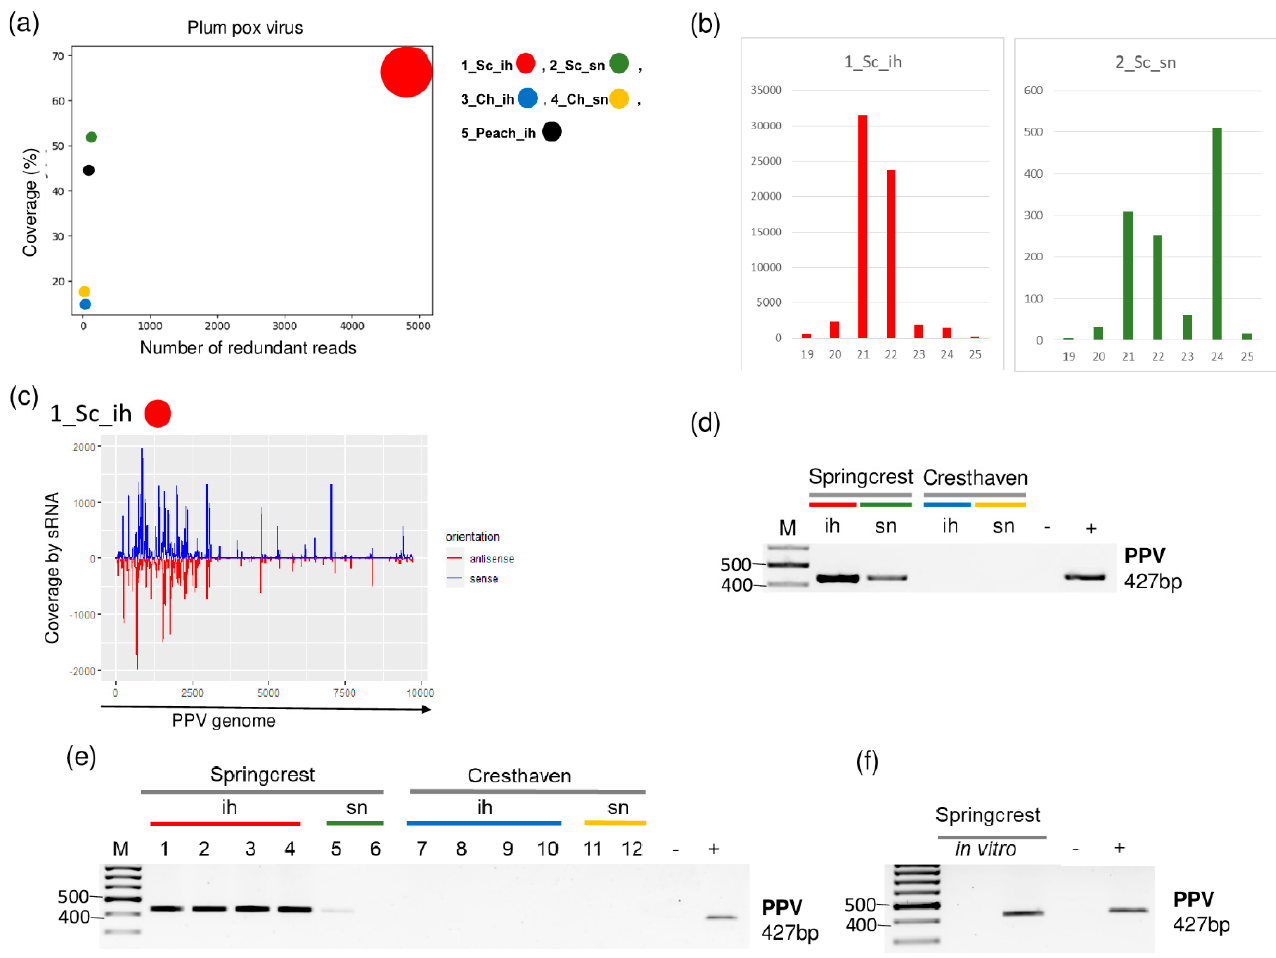
Figure 2. The result of the sRNA HTS and its validation for PPV in the five sRNA libraries. ( a ) The graphic representation of the result of the bioinformatics analysis of sRNA HTS. The coverage of the PPV genome ( y -axis) together with the number of RPM (number of PPV-specific non-redundant reads in 1 million sequenced reads, on the x -axis) was plotted as a circle whose diameter is proportional to the number of contigs. Different colors were used for the five libraries, as indicated. ( b ) The size class distribution of the PPV-derived reads in 1_Sc_ih and 2_Sc_sn libraries. ( c ) PPV-derived reads in the 1_Sc_ih library are shown as they mapped to the PPV genome, indicating their sense and antisense origin. ( d ) The result of RT-PCR validation for the presence of PPV in the 1–4 sRNA HTS libraries using PPV-specific primers amplifying a 427 bp virus-specific amplicon. ( e ) The result of the RT-PCR validation for the presence of PPV in individual trees of 1–4 sRNA libraries using virus-specific primers amplifying a 427 bp virus-specific amplicon. ( f ) The result of the RT-PCR validation of PPV in in vitro plantlets whose ancestors were used, using PPV-specific primers amplifying a 427 bp virus-specific amplicon. M is a GeneRuler 100 bp from Thermo Scientific (Waltham, MA, USA). Sc: Springcrest; Ch: Cresthaven; ih: isolator house; sn: stock nursery, + is a positive control while − is a negative